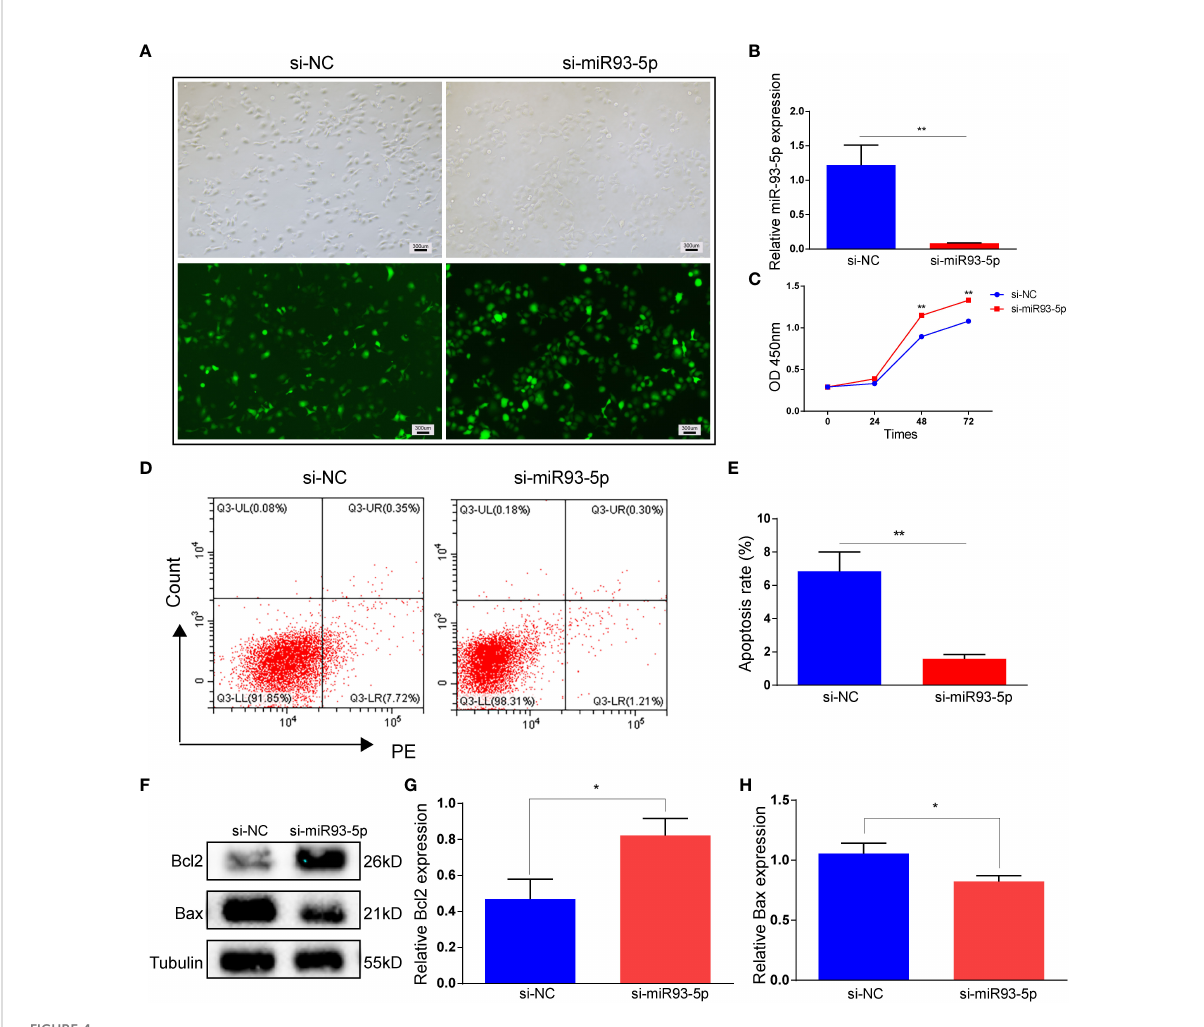
FIGURE 4 The effect of inhibition of miR-93-5p on the apoptosis in GC. (A) Cells were transfected with the si-NC and si-miR93-5p lentivirus. (B) The expression of miR-93-5p in GC detected by RT-qPCR. (C) Cell viability in the si-NC and si-miR93-5p groups detected by CCK-8 assay. (D, E) Flow cytometry assay displayed the apoptosis level in two groups and bar charts are used for visualization. (F, G) Bax and Bcl-2 protein expression were determined by western blotting in two groups. p < 0.05 ( “ * ” ), p < 0.01 ( “ ** ” ). GC, granulosa cell; RT-qPCR, reverse transcription quantitative polymerase chain reaction; CCK-8, cell counting